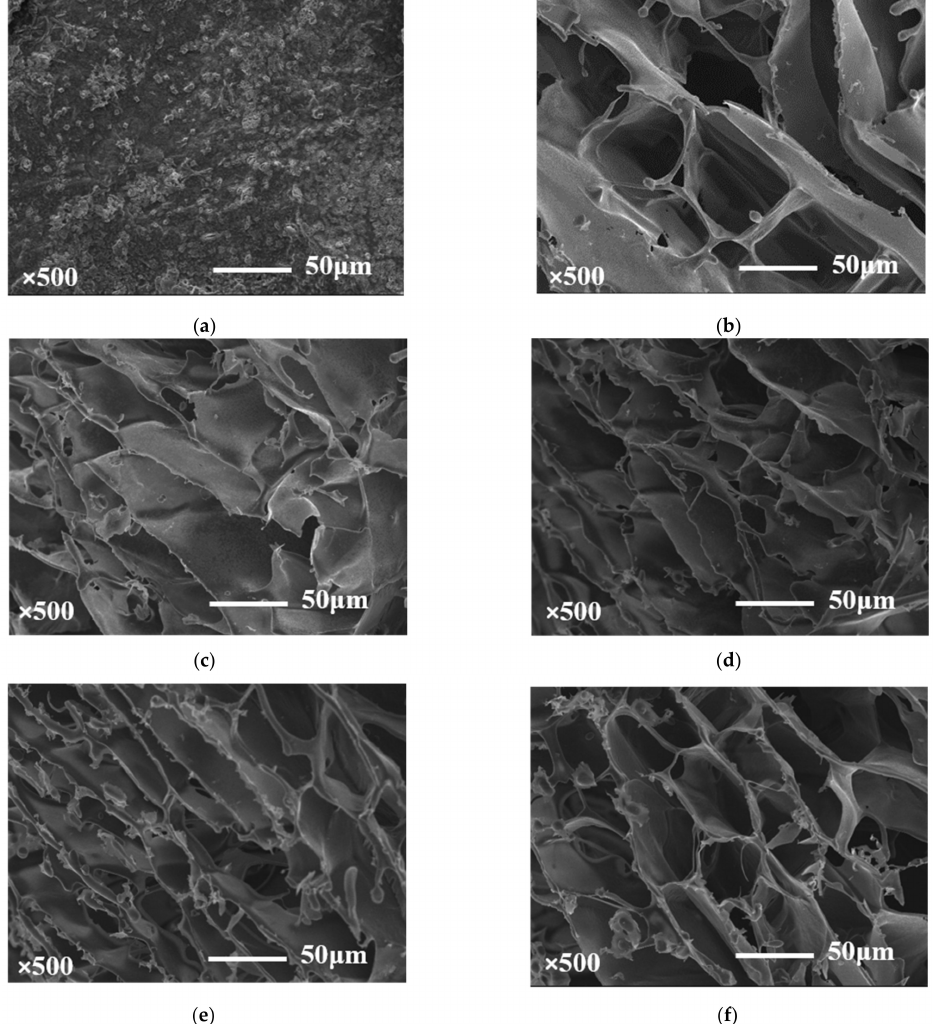
Figure 6. Scanning electron microscopy observations (SEM) of KGM gel ( a ), KOBG-1 ( b ), KOBG-2 ( c ), KOBG-3 ( d ), KOBG-4 ( e ) and KOBG-5 ( f